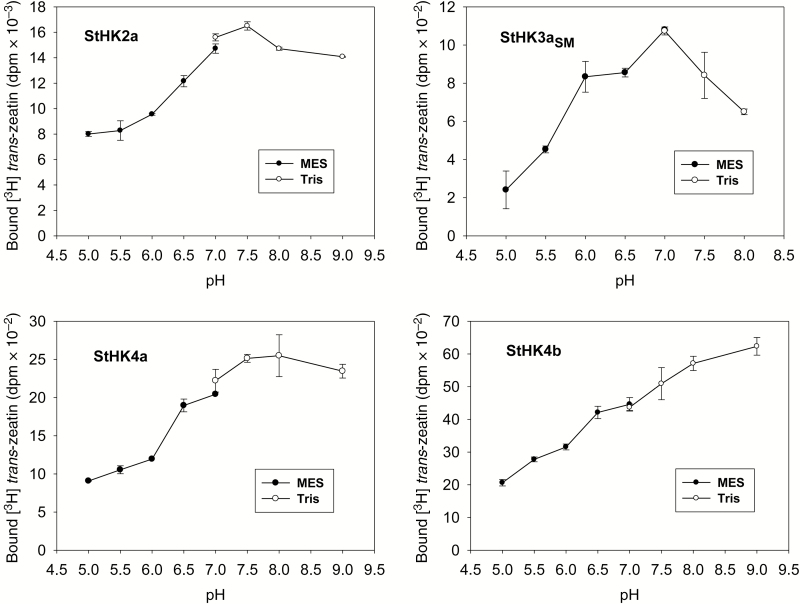
pH dependencies of trans-zeatin binding to putative potato CK receptors.